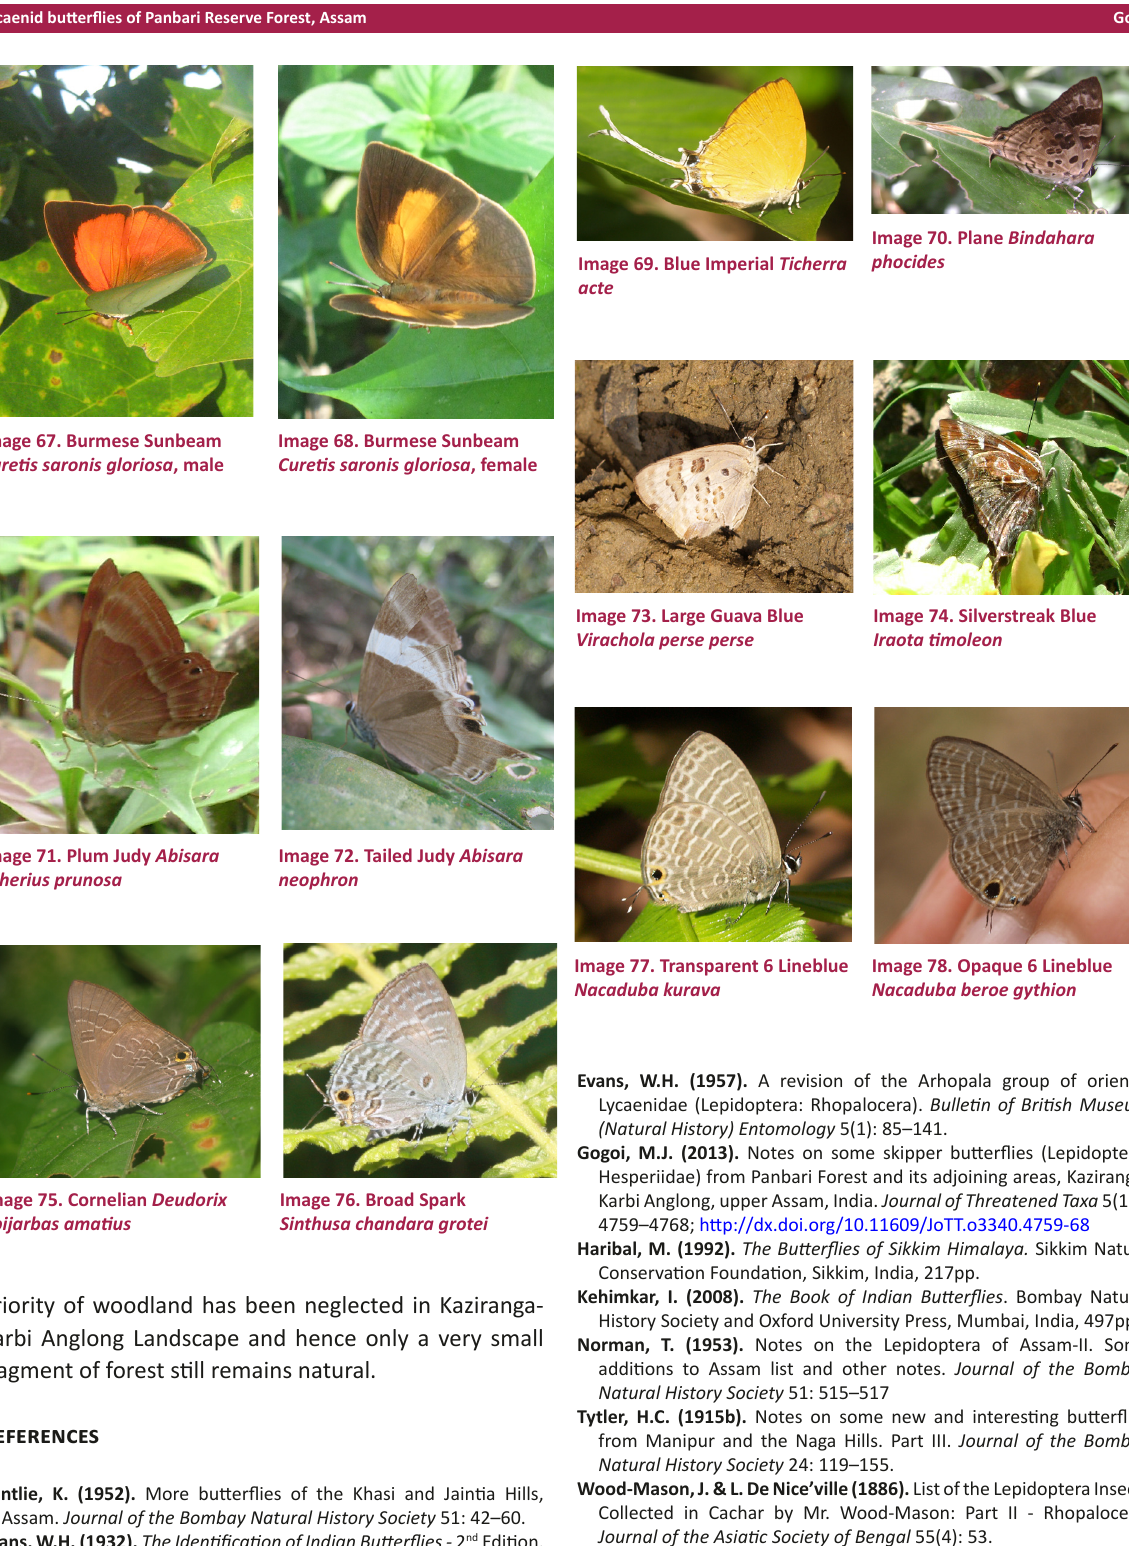
Image 69. Blue Imperial Ticherra acte